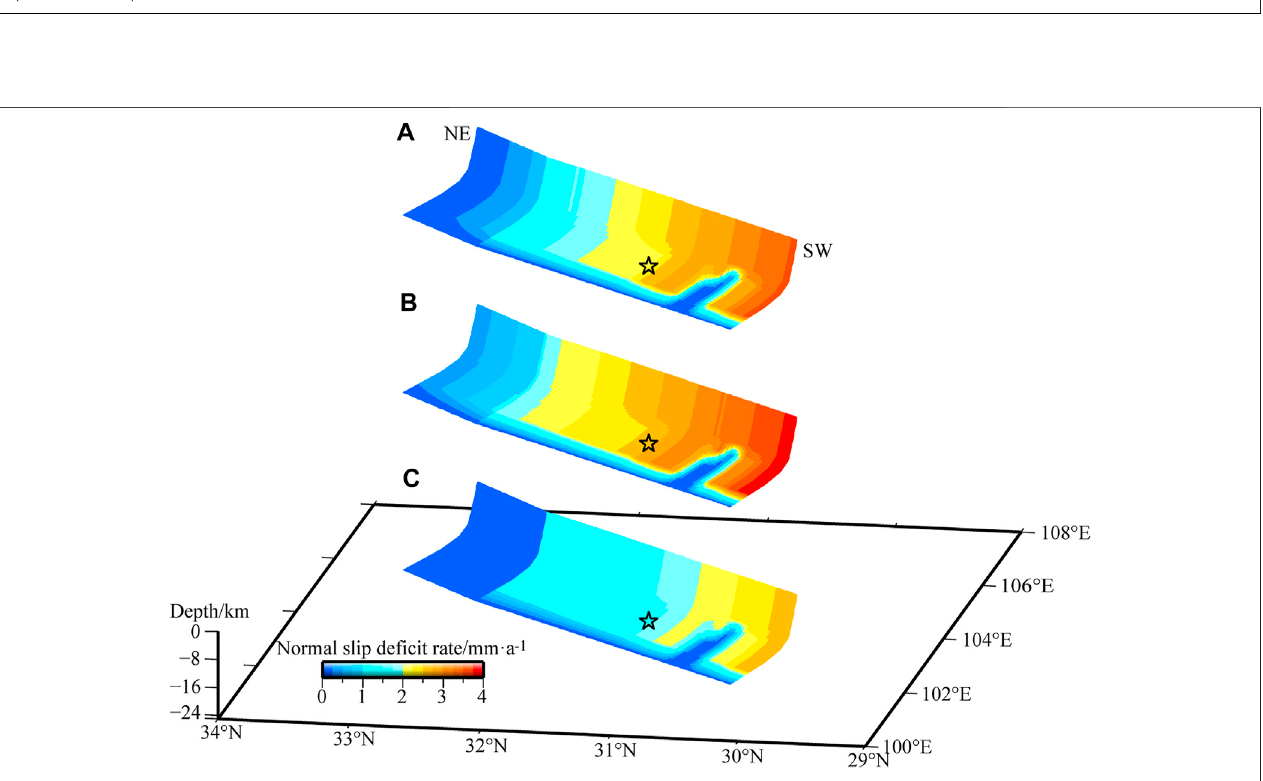
FIGURE3| Spatialdistributionoffault-normalslipde fi citratesduring (A) 1999 – 2001, (B) 2001 – 2004,and (C) 2004 – 2007alongtheLongmenshanfaultplane.The black star denotes the Wenchuan earthquake source location.